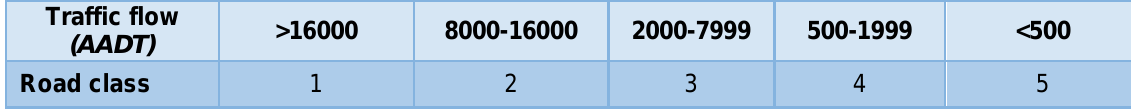
Table 2 Road classification in Sweden (Source: STA